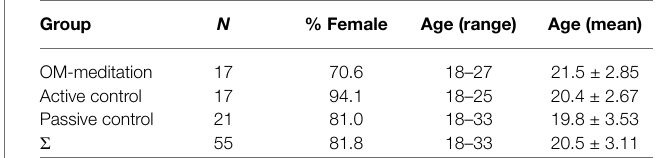
TABLE 1 | Sample by